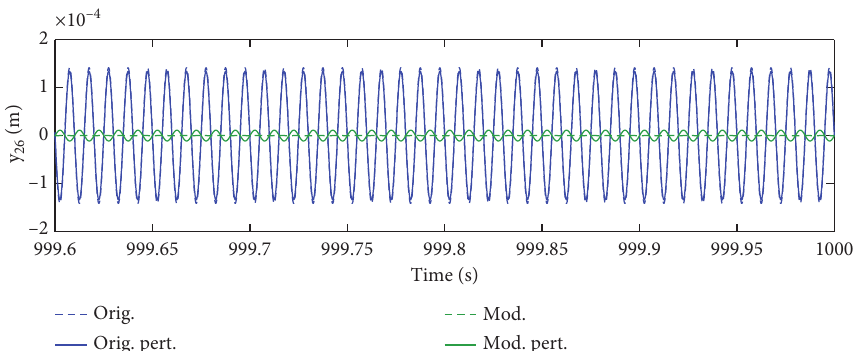
Figure 11: Test-case 4: steady-state response of the original and modified systems without and with mass m